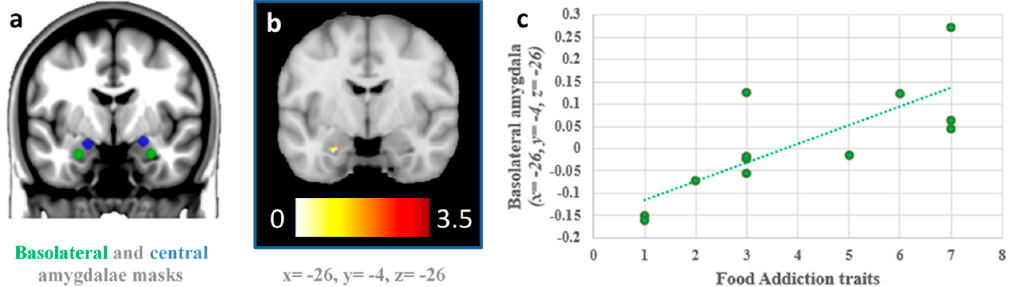
Figure 3. Association between the activation of the left basolateral amygdala and food addiction traits, ( a ) location of the basolateral (green) and central (blue) amygdala seeds, used as a mask for small-volume corrections; ( b ) left basolateral amygdala significantly associated with food addiction traits during the fasted session ( p SVC-FWE < 0.05 = 0.042); ( c ) scatter plot represents the correlation between the change in the activation of the left basolateral amygdala from the fasted to the fed sessions (y-axis) and food addiction traits (x-axis) (x = − 26, y = − 4, z = − 26, t = 3.77, p SVC-FWE<0.05 = 0.027).